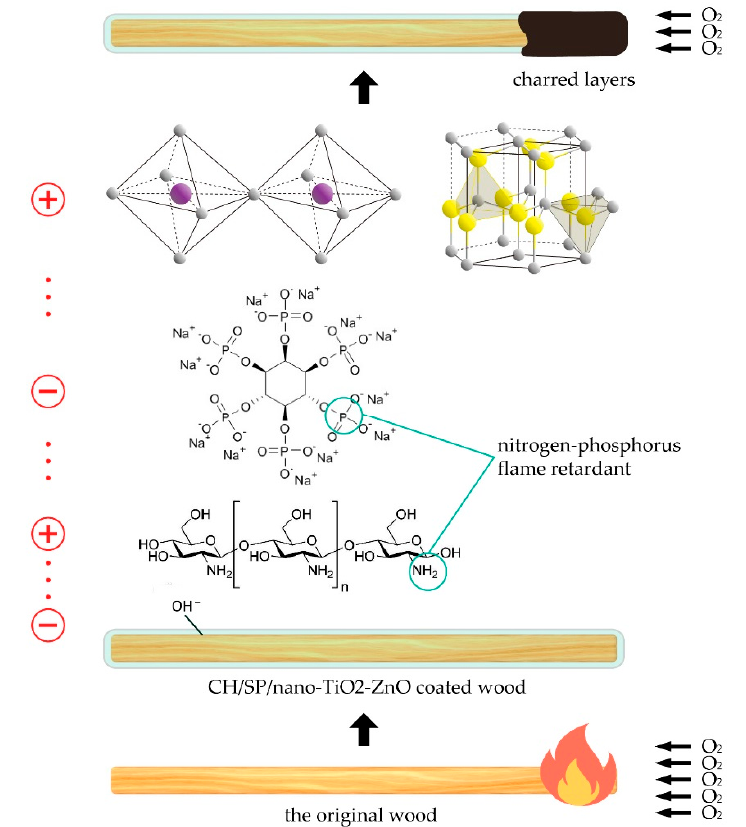
Figure 6. Flame retardancy mechanism of CH/SP/nano-TiO 2 -ZnO composite film.